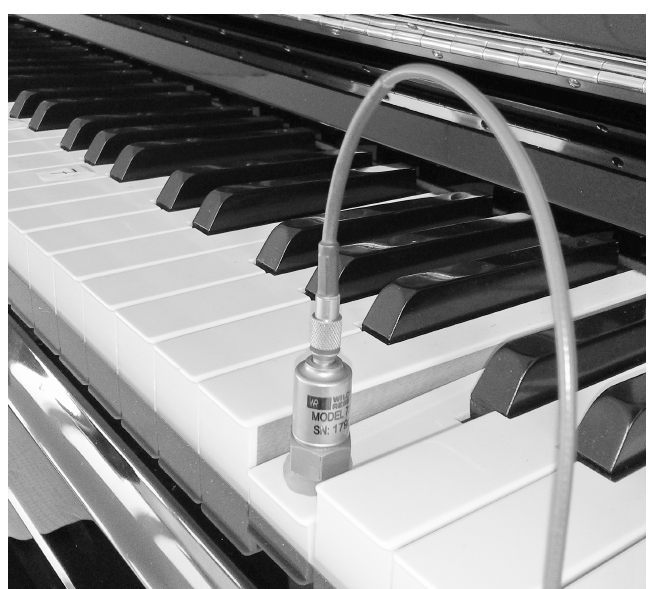
Figure 2. Vibration recording setup. A Wilcoxon Research 736 accelerometer is attached with adhesive tape to a key that is being played remotely via MIDI